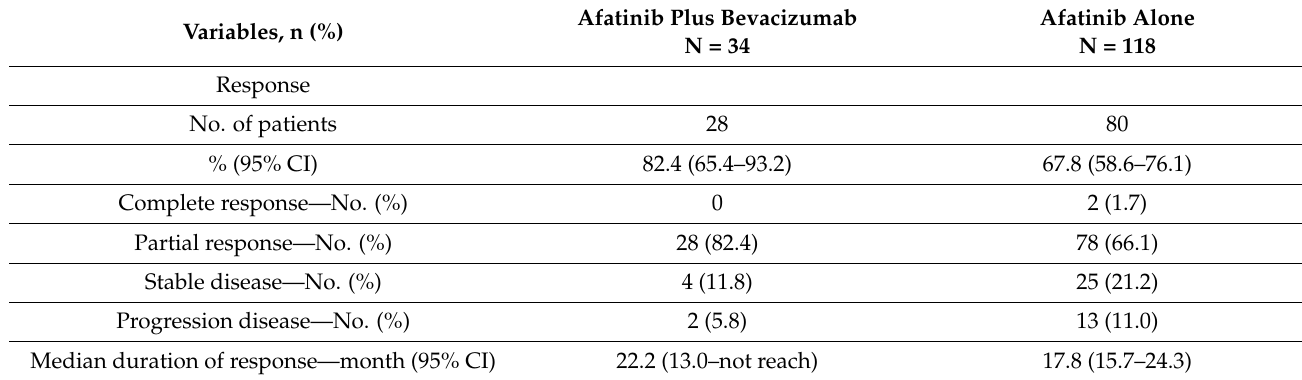
Table 3. Objective response in the propensity score-matched